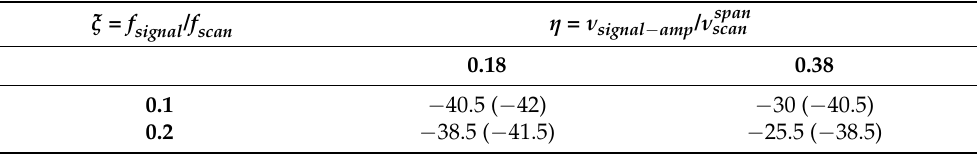
Table 1. Normalized second harmonic levels (in units of dBc) of the longitudinally vibrating fiber of Figure 12 for two scaled vibration frequencies and two scaled amplitudes. Main values are the measurements of the CFG dynamic interrogator, while those in parentheses were obtained from the uniformly triggered interrogator of the single, in-line